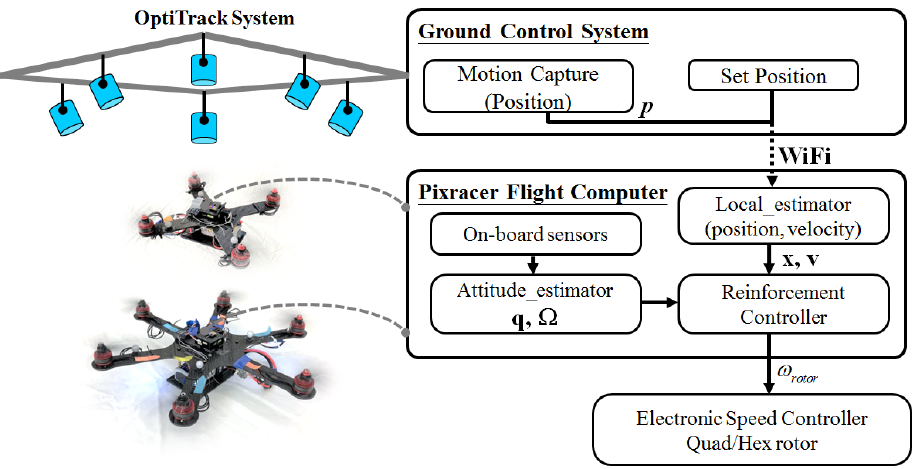
Figure 9. The motion capture framework (OptiTrack Prime 13, 1.3 MP Resolution, 240 FPS) for real-world verification is exploited to interface with the vehicles. The trained policy and control structure are implemented using Pixracer flight controller and WiFi connection to achieve position feedback with wireless